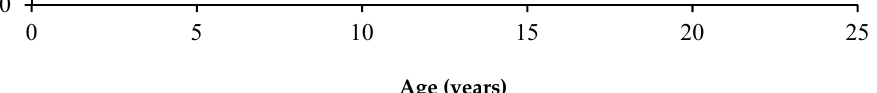
Figure 2. Length-at-age data of totoaba, Totoaba macdonaldi , used in the present study. Lines show growth trajectories of the most plausible model (vB using the observed variance) with 95% confidence intervals.